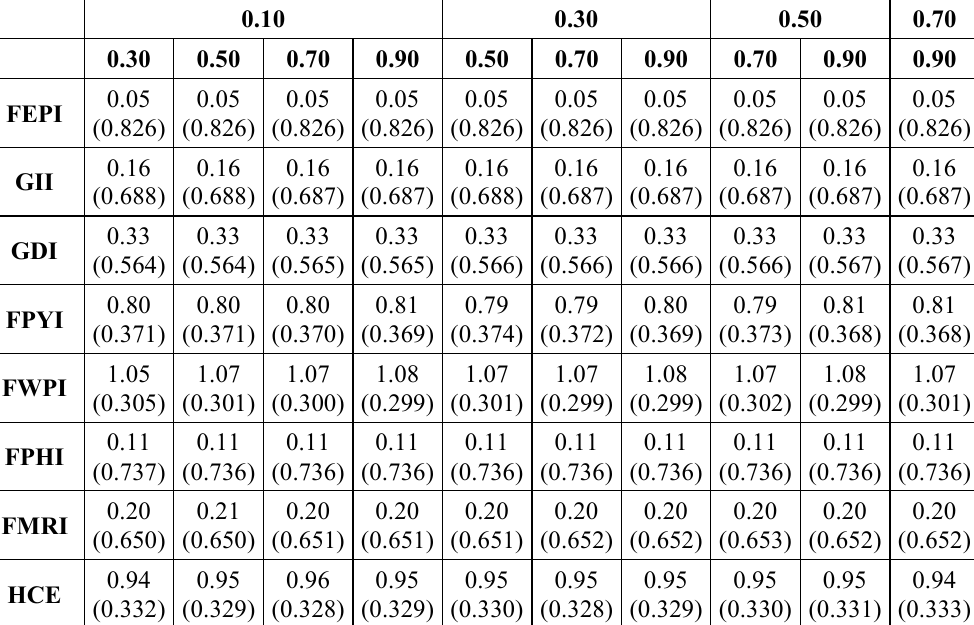
Table 3. Wald Tests for the Coefficient